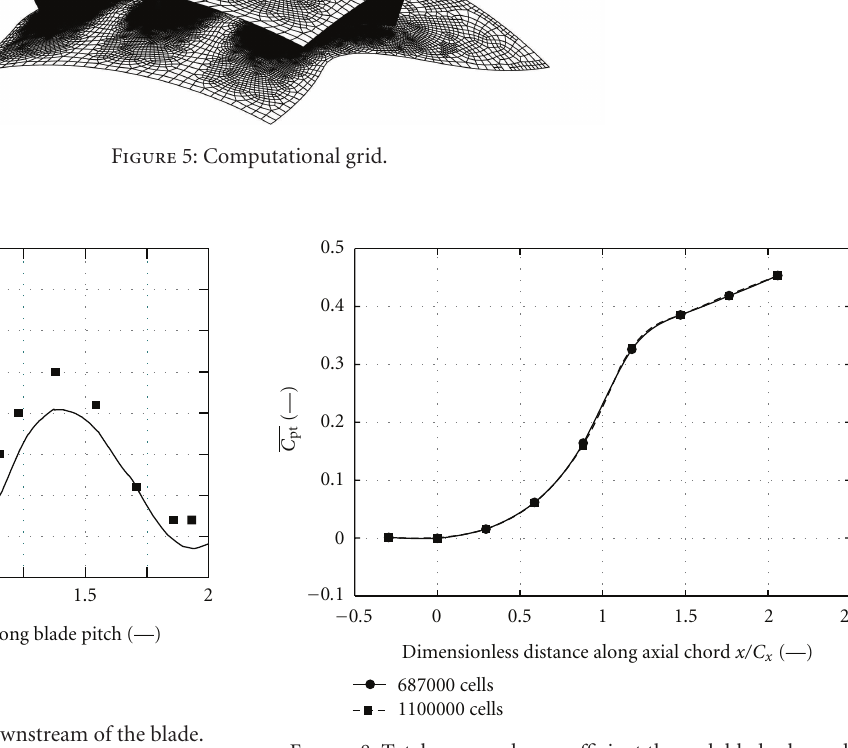
Figure 8: Total pressure loss coe ffi cient through blade channel.